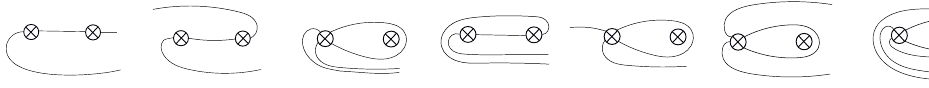
Figure 22. Examples for u i –straight arcs in S (cid:48)